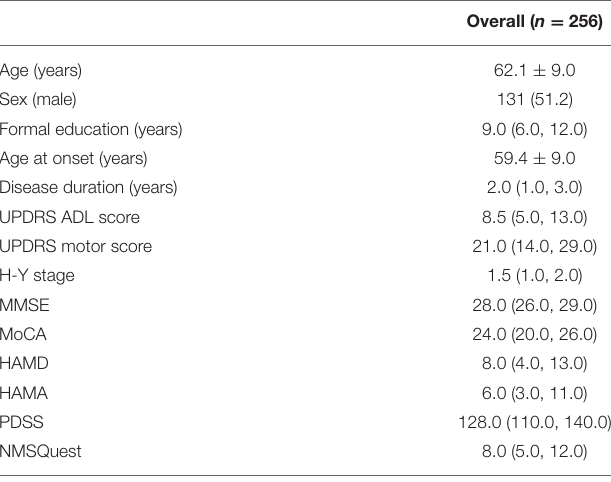
TABLE 1 | Demographic and clinical characteristics of de novo Parkinson’s disease